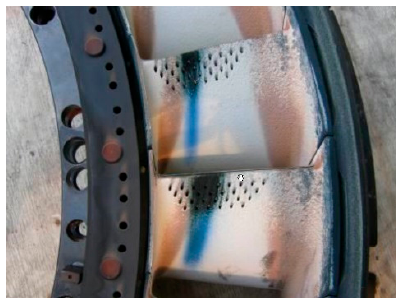
Figure 4. Overheated turbine vane inside machine.